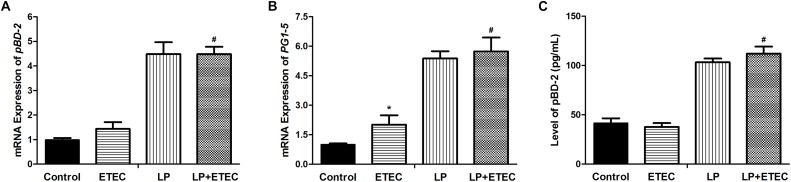
Relative mRNA transcript levels of pBD2
(A) and PG1-5
(B) and concentrations of pBD2 (C) in the culture supernatant of IPEC-J2 cells left untreated or pretreated with L. plantarum ZLP001 (LP, 108 CFU mL−1) for 6 h and then challenged or not with 106 CFU mL−1 ETEC for 3 h. mRNA expression levels were standardized to that of GAPDH. Expression levels relative to non-treated controls were calculated by the 2−ΔΔCT method. The pBD2 concentration was assessed by ELISA. Values are shown as the means ± SE of three independent experiments. ∗P < 0.05 vs. non-treated controls; #P < 0.05 vs. ETEC alone.